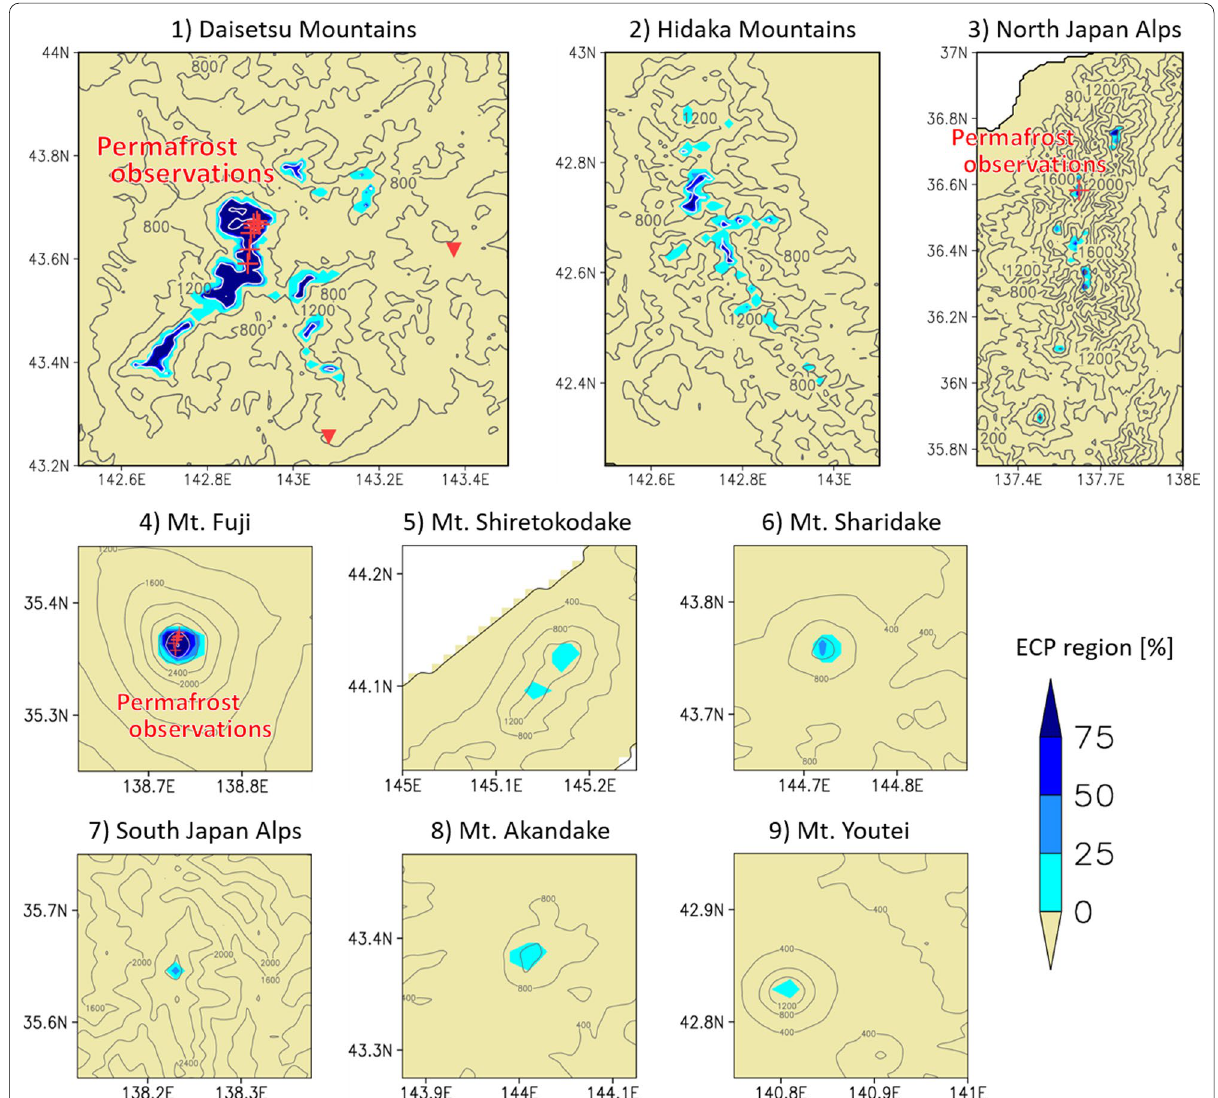
Fig. 2 Distribution of regions with surface air temperatures that favor the maintenance of permafrost (the Environmentally Conditioned Permafrost regions) in Japan under the current climate conditions (averaged over 1999–2018); (1) Daisetsu Mountains, (2) Hidaka Mountains, (3) Northern Japan Alps, (4) Mt. Fuji, (5) Mt. Shiretokodake, (6) Mt. Sharidake, (7) Southern Japan Alps, (8) Mt. Akandake, and (9) Mt. Yotei. The distribution of the environmentally conditioned permafrost region is based on probabilities estimated by nine bias-corrected climate scenarios. Red points indicate sites where permafrost has been observed. The observations of sporadic permafrost in Shikaribetsu and Oketo are shown as ▼ , and other observations are shown as . See Additional file 1: Table S1 for details. The contour interval is 400 +